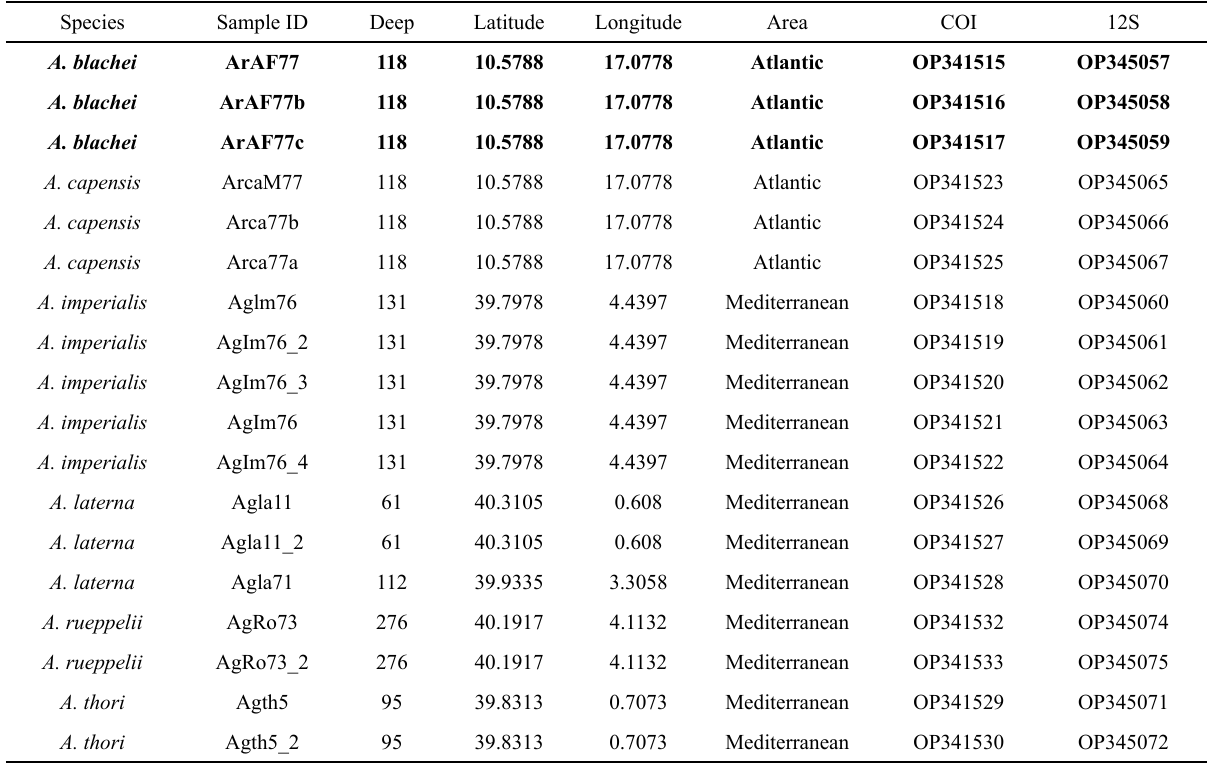
Table 2. – Geographic information and GenBank identifiers for both mitochondrial fragments ( COI and 12s RNA ) for genetic samples of the studied species of Arnoglossus . The samples of A. blachei are printed in bold face.